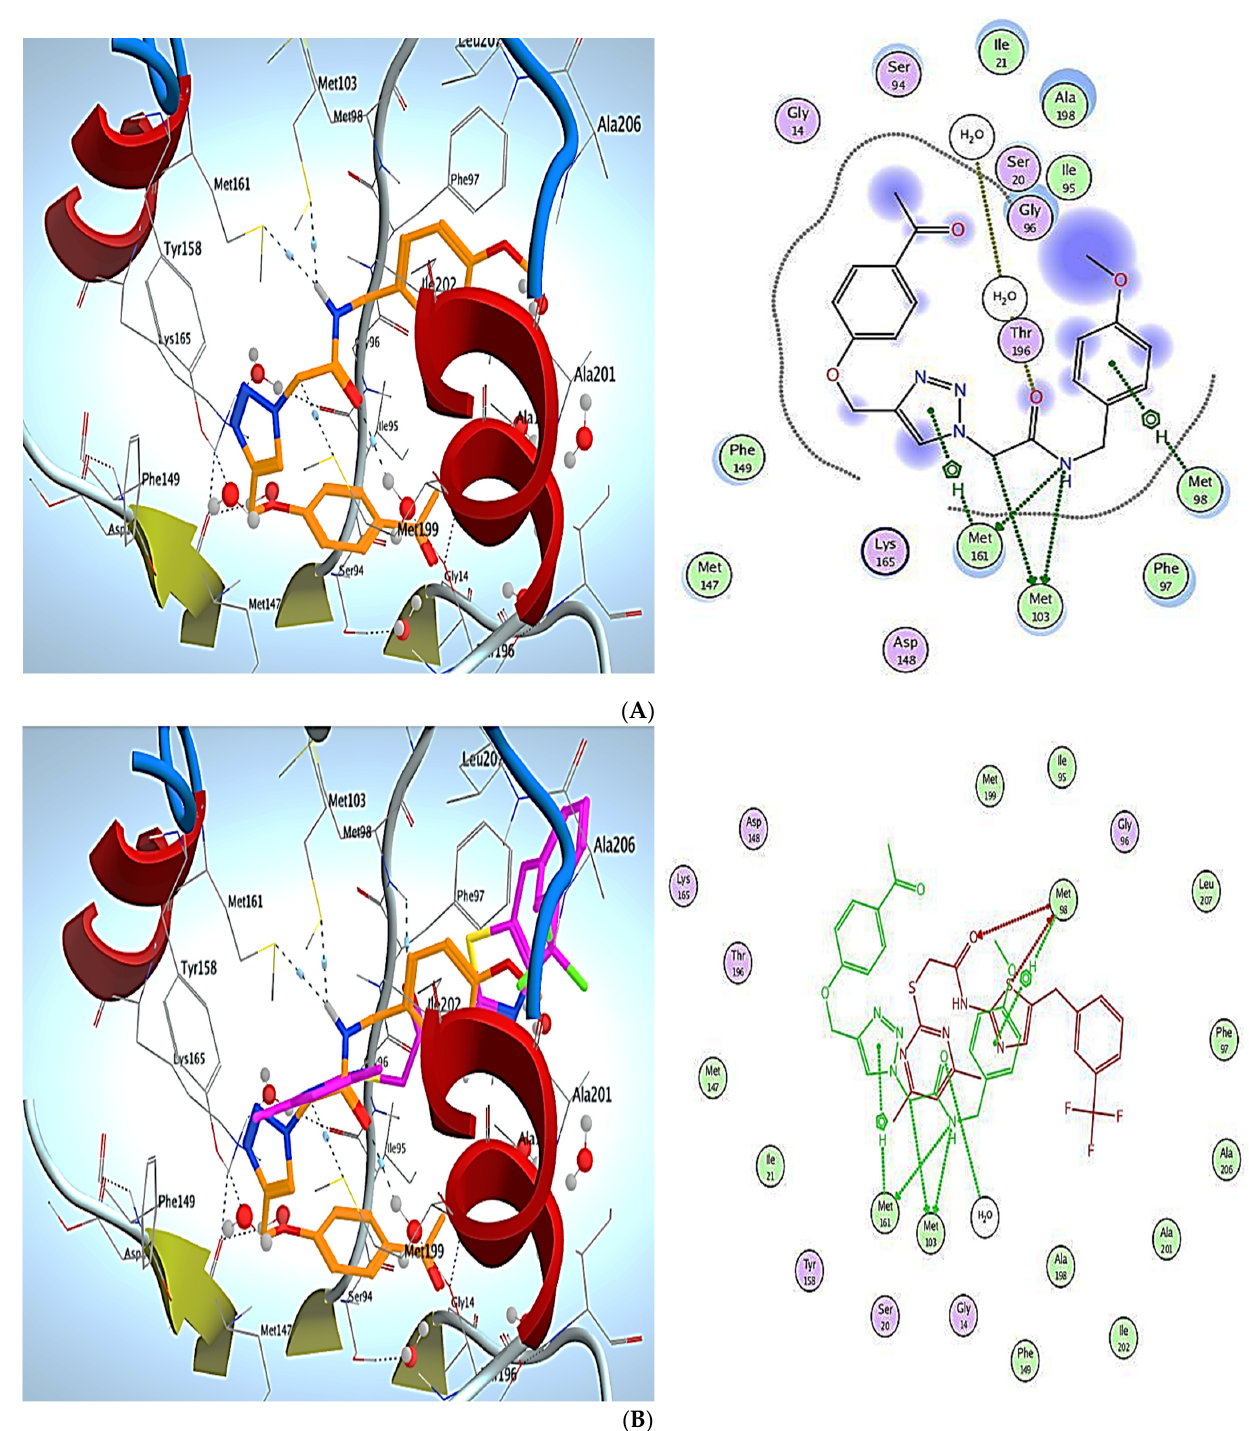
Figure 7. ( A ) Docking and binding pattern of compound 14 into InhA active site (PDB ID: 4UVD) in 2D (right panel) and 3D (left panel). ( B ): An overlay of the docked pose of compound 14 (brown) with the co-crystallized ligand (purple) into InhA active site in 2D (right panel) and 3D (left panel).